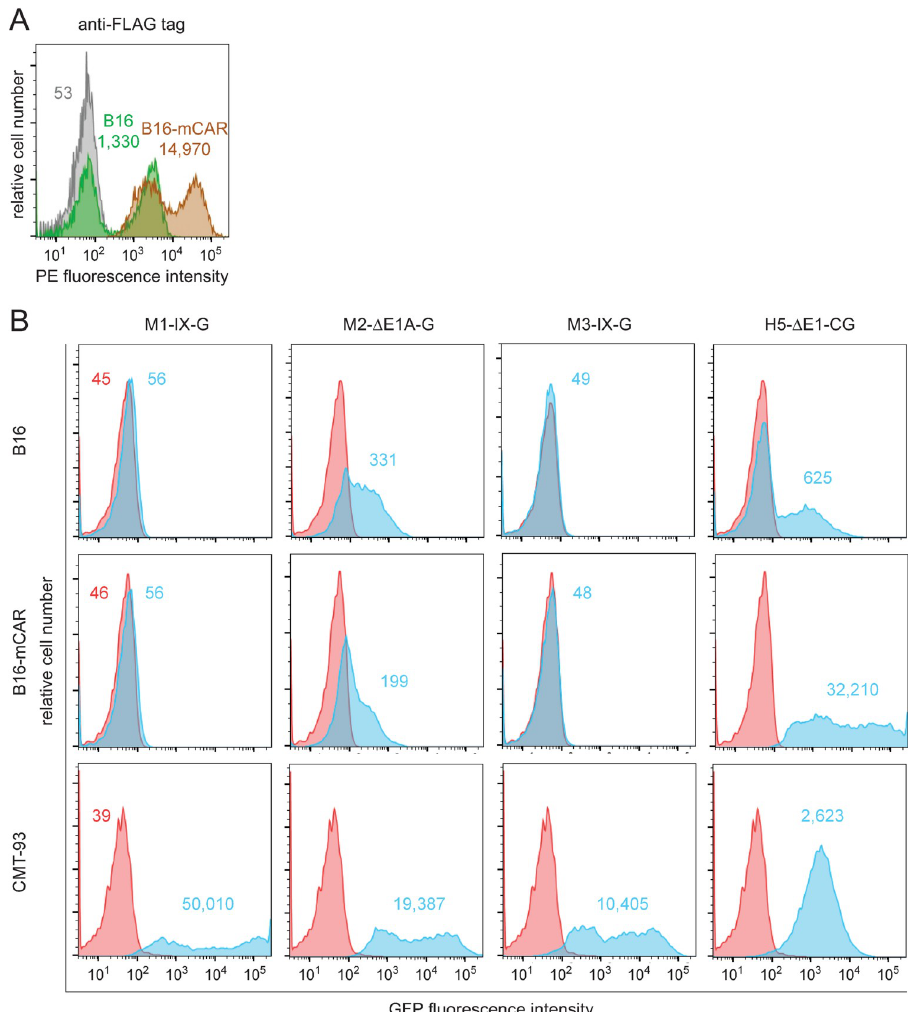
Fig 3. Evaluation of mCAR as receptor for M1/M2/M3. (A) The green and brown histograms show cytofluorometric analysis of FLAG-tag expression levels in parental B16 and B16-mCAR cells, consisting of B16 cells stably expressing N-terminal FLAG-tagged mCAR, respectively. The grey histogram shows background staining of B16-mCAR cells using a matched isotype control. Numbers indicate MFI values of specific or control antibodies. (B) Parental B16 cells with known low, and CMT-93 cells with high sensitivity for H5- Δ E1-CG, plus B16-mCAR cells were infected with M1-IX-G, M2- Δ E1A-G, M3-IX-G and H5- Δ E1-CG using an MOI of 15 for both B16 cell types, and an MOI of 3 for CMT-93 cells. Cells were analyzed by flow cytometry 48 h pi. MFI values for GFP in red and blue histograms are from uninfected and infected cells,